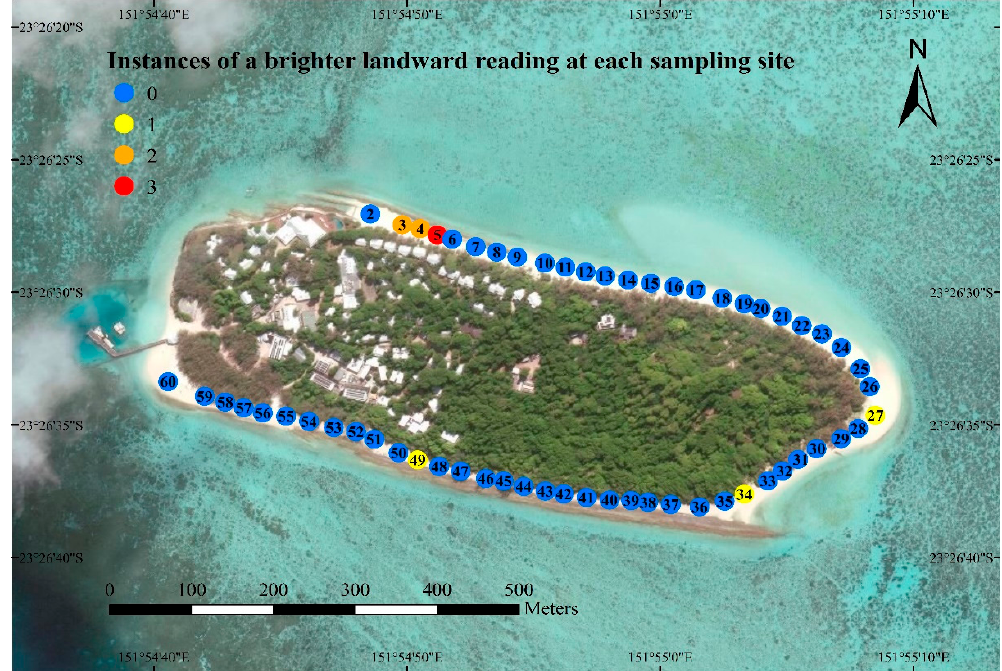
Figure 9. Map of Heron Island demonstrating the number of instances in which the landward horizon was on average brighter (V mag/arcsec2) than the seaward horizon, at each sampling site.